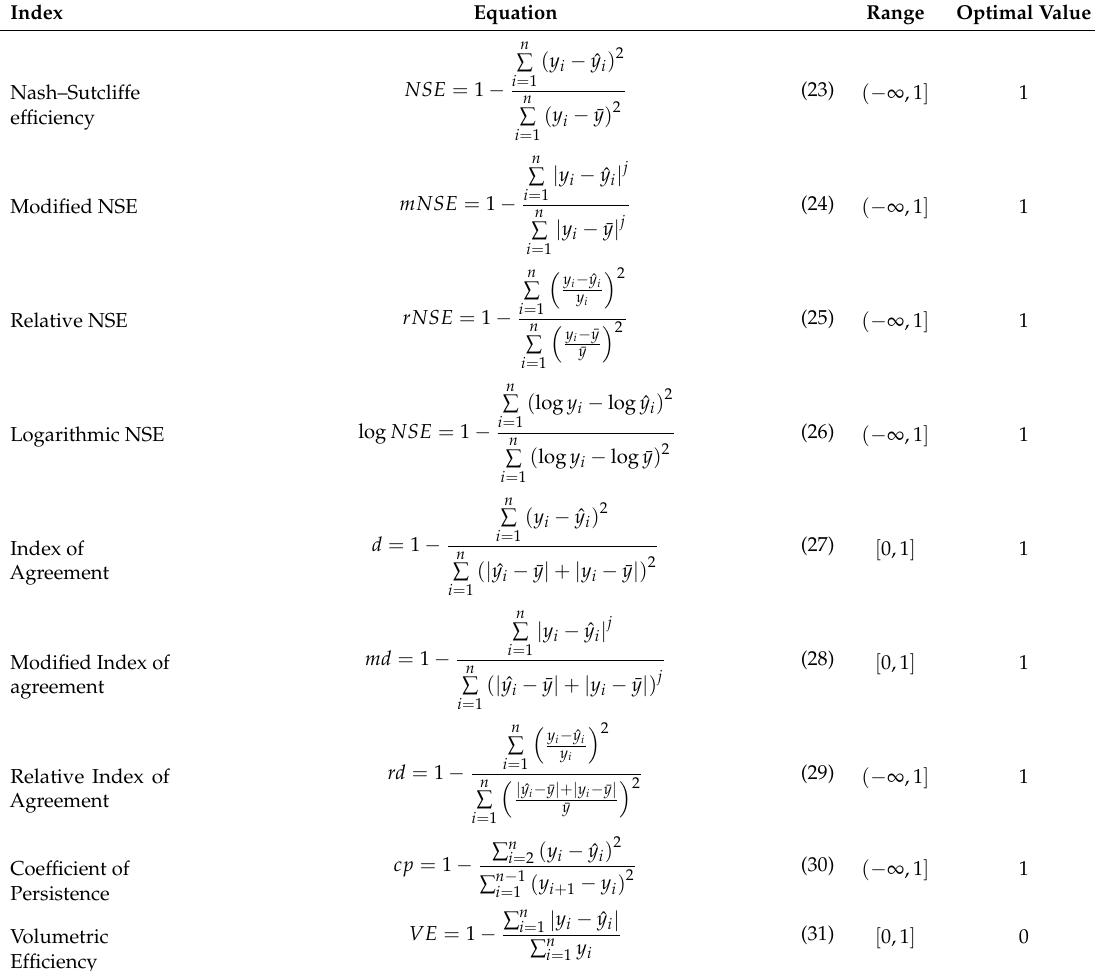
Table 5. Efficiency criteria.